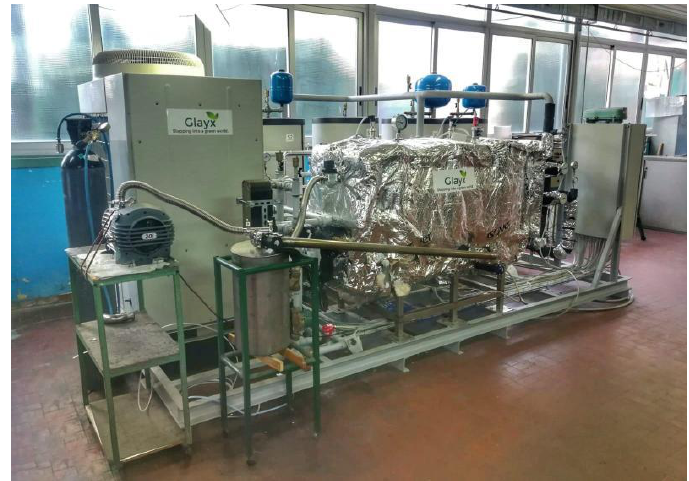
Figure 5. Experimental set-up.